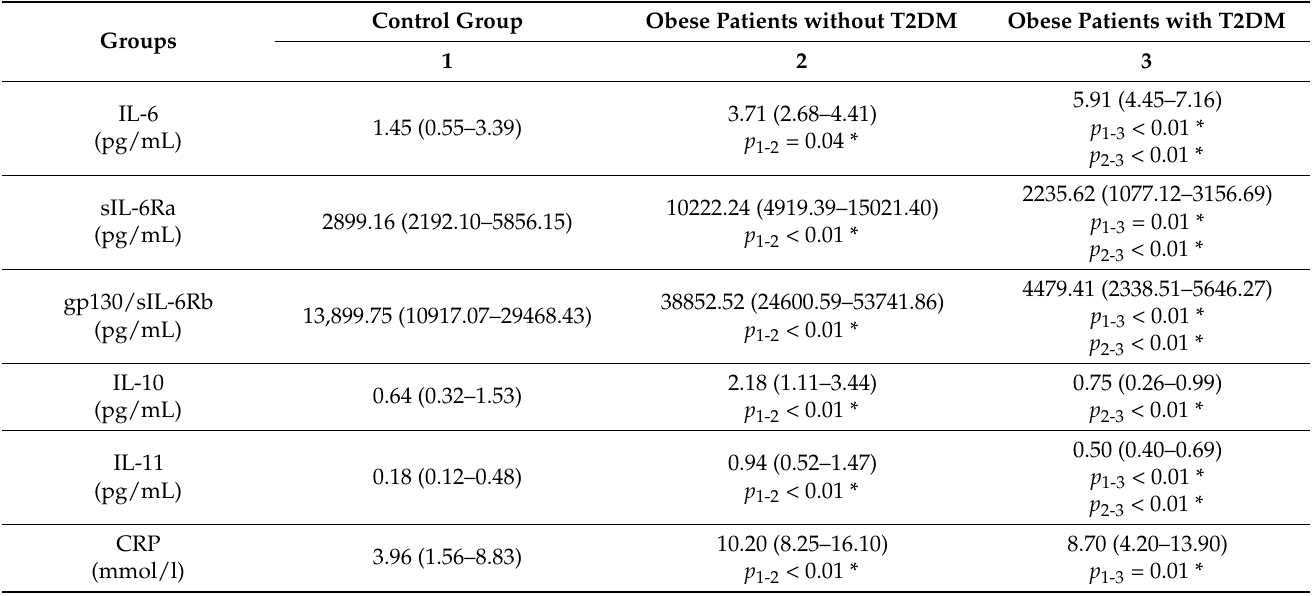
Table 3. Basic biochemical parameters of liver enzymes in obese patients with and without T2DM. Control Group Obese Patients without T2DM Obese Patients with T2DM Groups 1 2